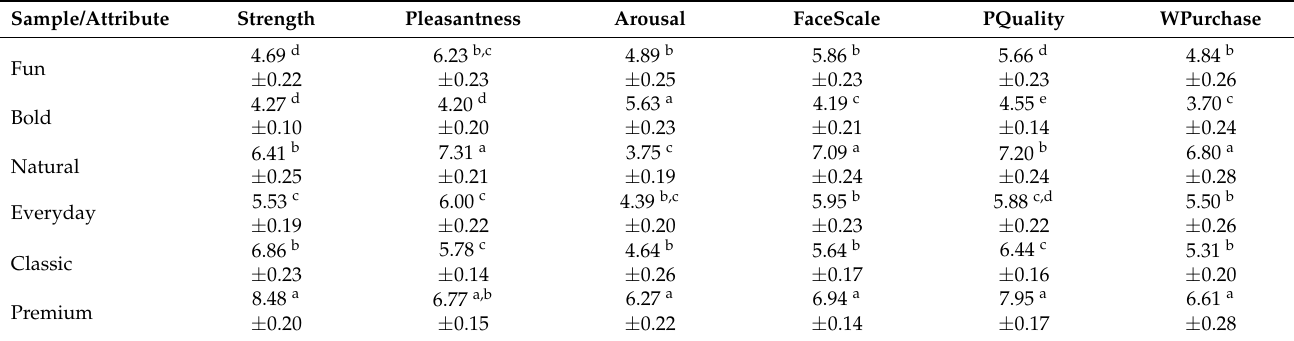
Table 1. Attributes assessed for acceptability of the coffee pod label samples. Table 3. Attributes obtained from the participants’ video analysis for emotional responses.